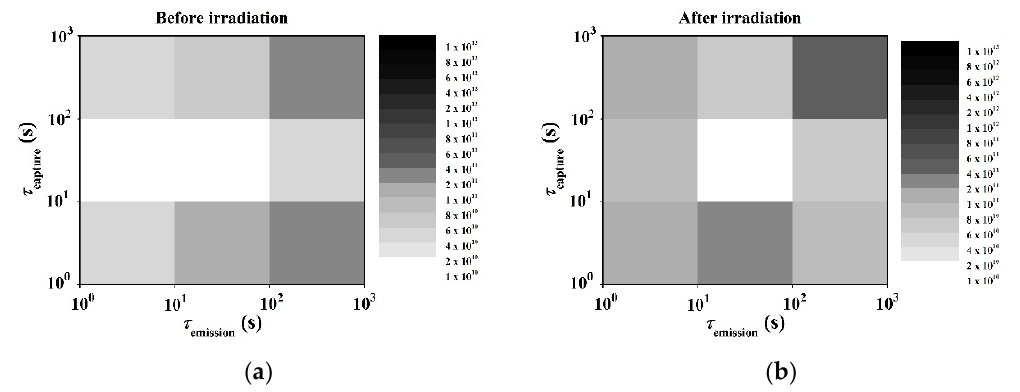
Figure 4. Capture emission time (CET) maps in normally-off AlGaN/GaN gate-recessed MISHFETs: ( a ) before proton irradiation and ( b ) after proton irradiation.